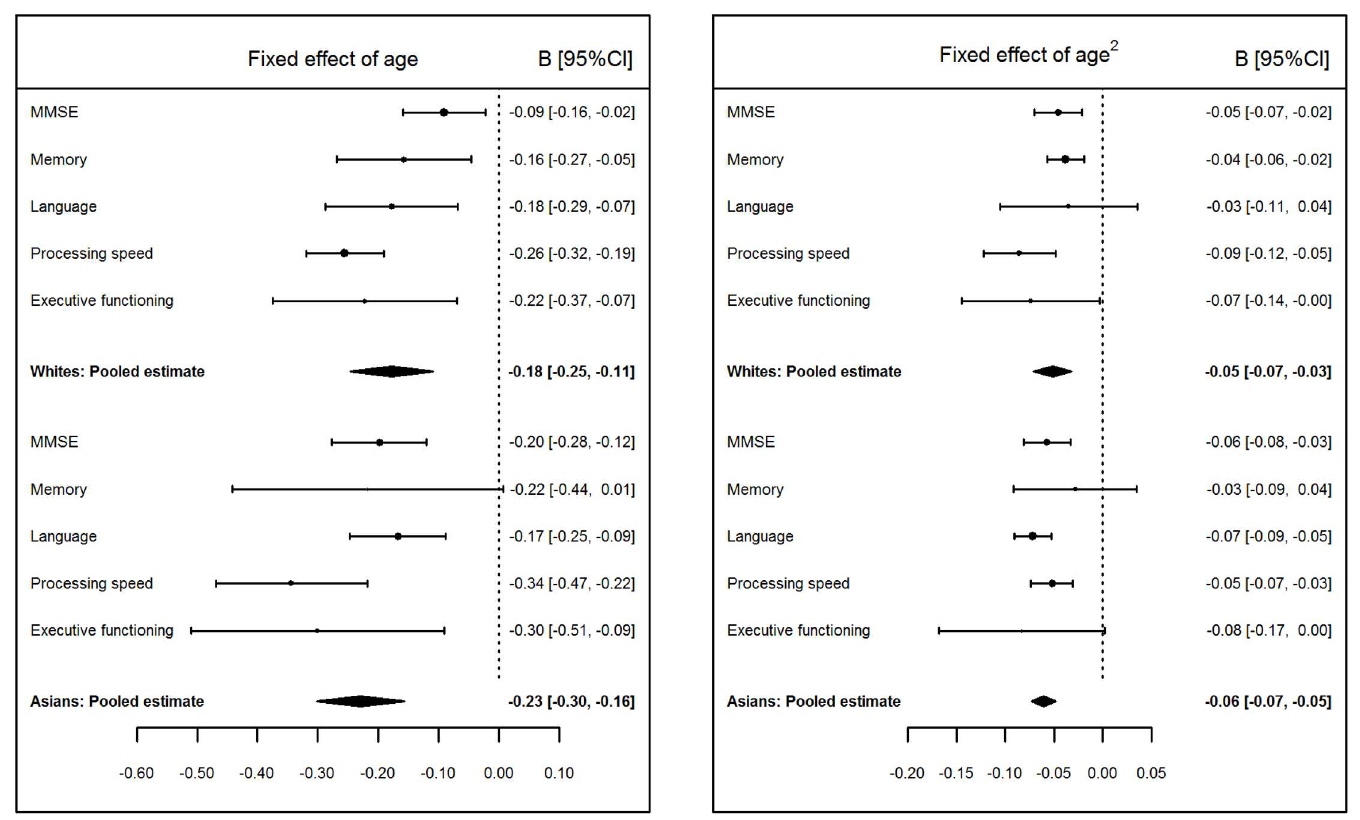
Fig 3. Pooled values of age and age 2 fixed effects on Mini-Mental State Examination (MMSE) and cognitive domain scores for white and Asian groups. The x -axis plots change in Z-score units per decade;negativevalues indicatedeclinewith age (left panel)and accelerating declinewith age (right